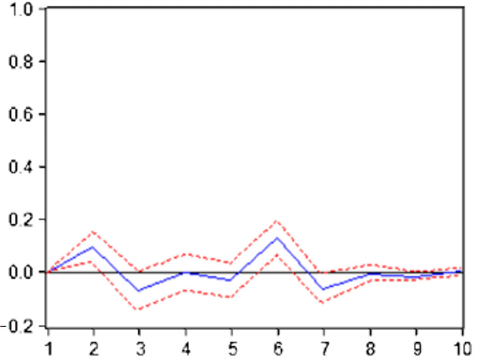
Figure 5. The impulse response of SHFE to COMEX copper yield.